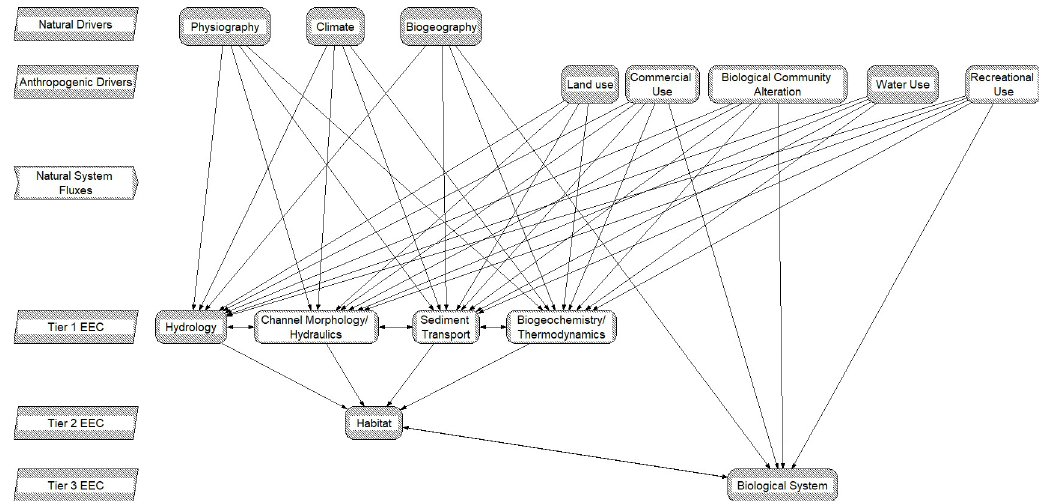
Fig 3. Tiered hierarchical conceptualization of how anthropogenic and natural drivers relate to physical and biological components of large-river ecosystems. Essential ecosystem characteristics (EECs) are groupings of ecosystem components. Tier 1 EECs represent physical and chemical effects; fundamental measures of process that are directly affected by anthropogenic and natural drivers. Tier 2 EECs represent a broad habitat category that is intended to encompass the physical, chemical, and biological components of the riverine habitats that influence reproduction, growth, and survival of biotic communities. The Tier 3 EEC represent components of the biological systems that respond to changes in the hierarchical components of the conceptual